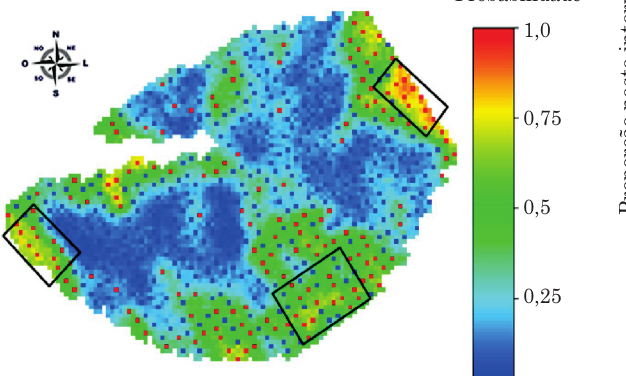
Figura 8. Gráfico de acurácia e estatística G para a SSG do fósforo